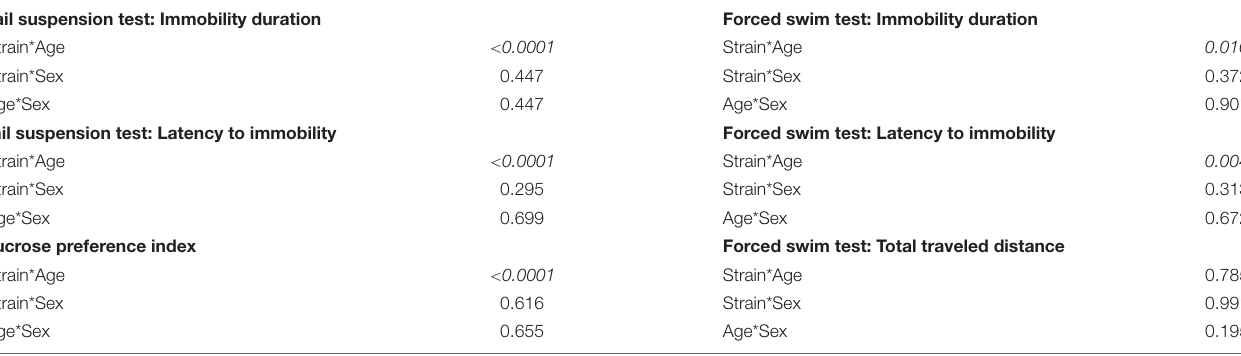
TABLE 3 | List of the Pr( > F ) after performing three-way ANOVA test to assess the effect of the interaction between strain, sex and age on the depression-like behavior. Tail suspension test: Immobility